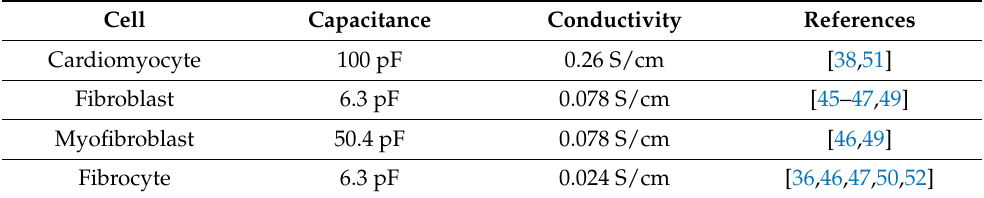
Table 1. Membrane capacitance and conductivity assigned to myocytes and fibrotic